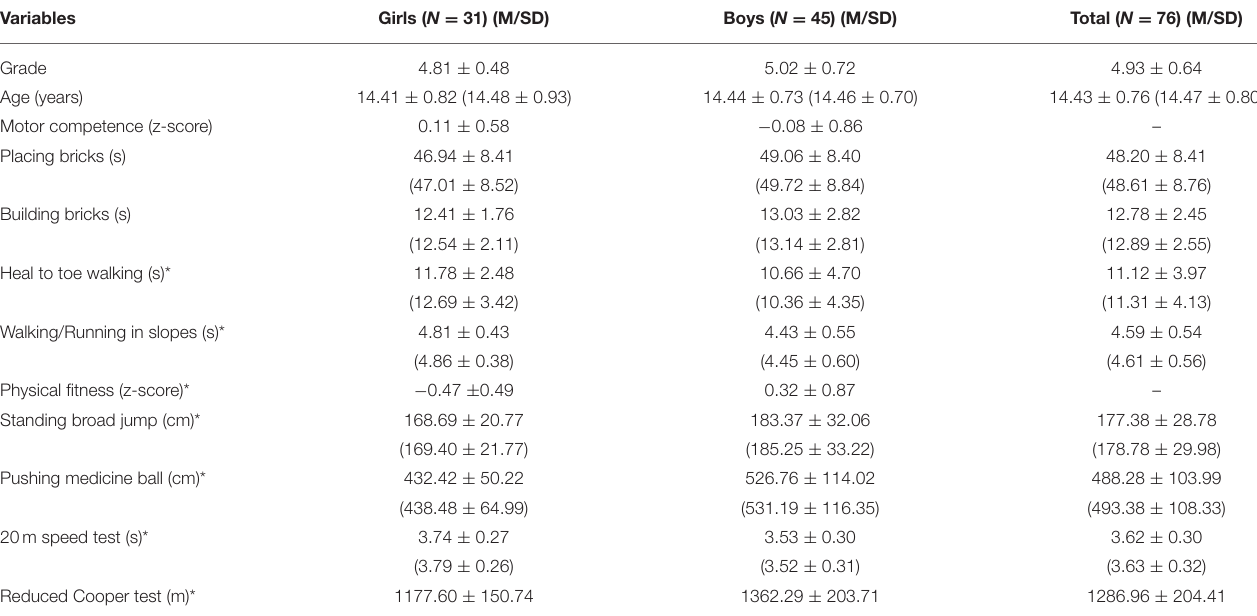
TABLE 1 | Grade, age, and measures of physical fitness and motor competence by gender ( N = 76).